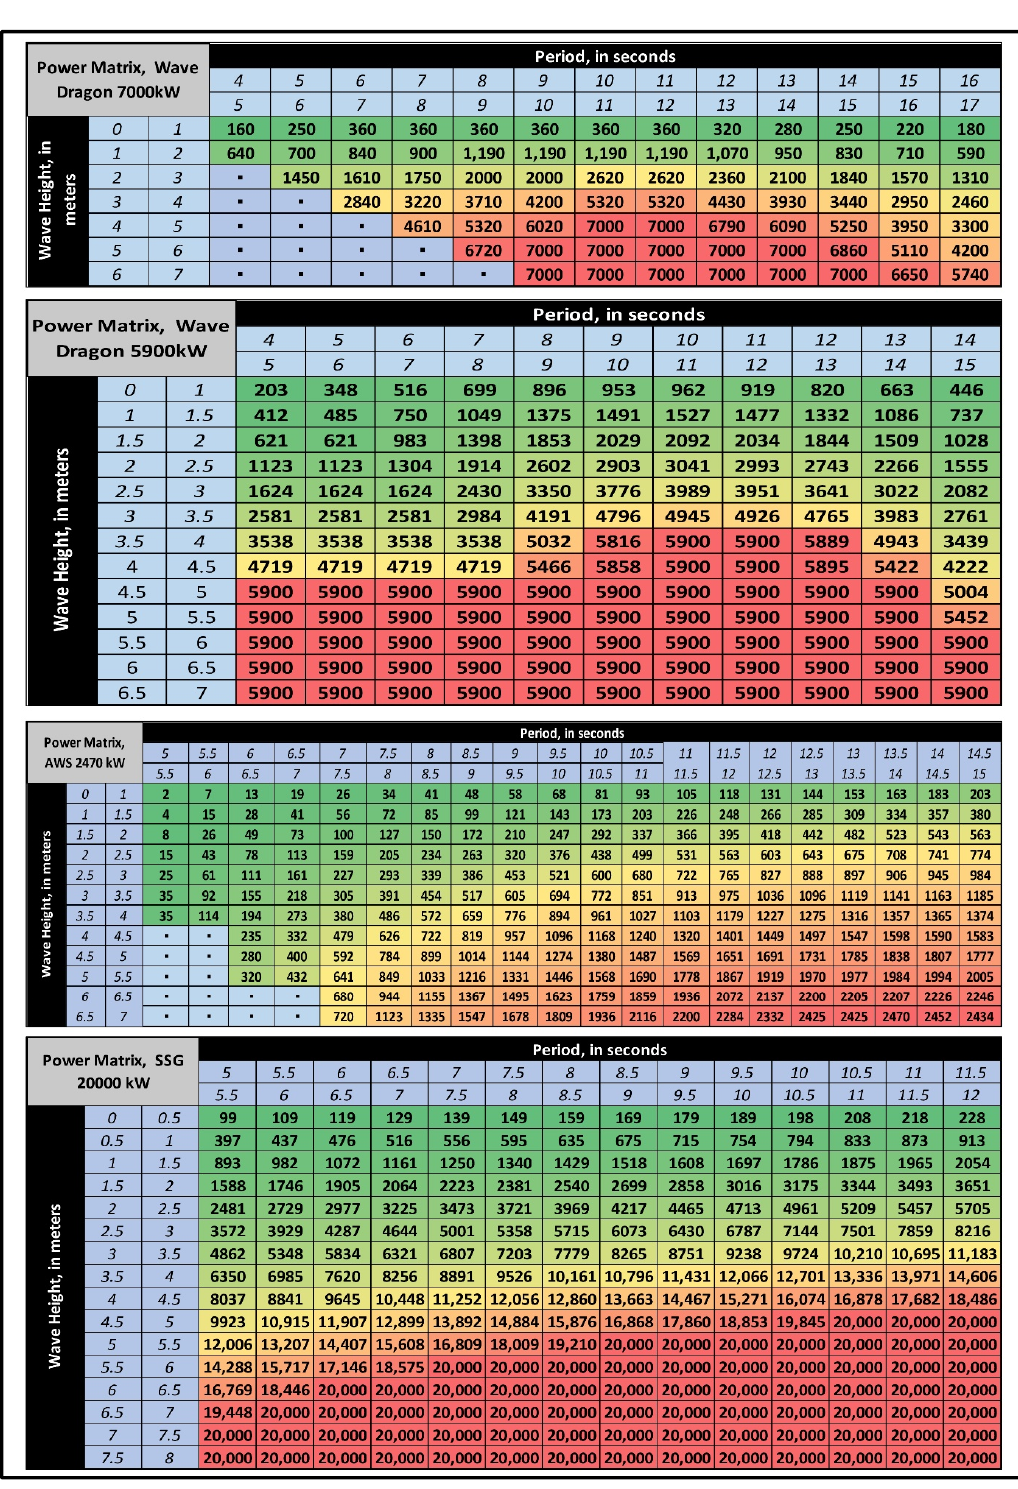
Figure A2. Power matrix of WD7, WD5.9, AWS and SSG.